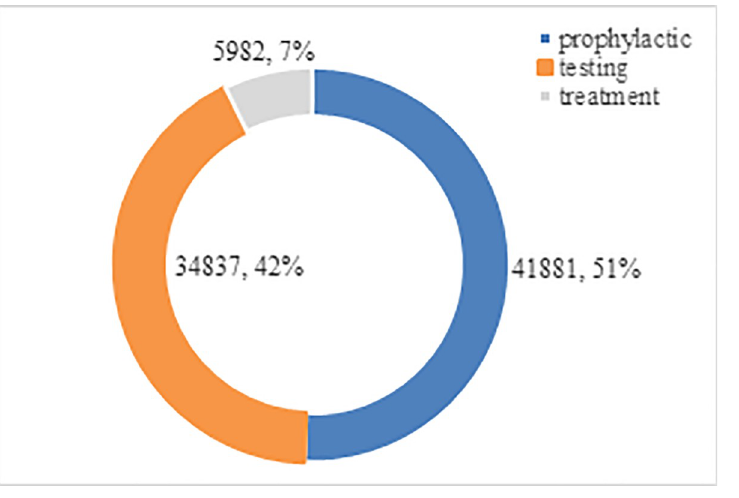
Fig 13. Distribution cost of the proposed method.